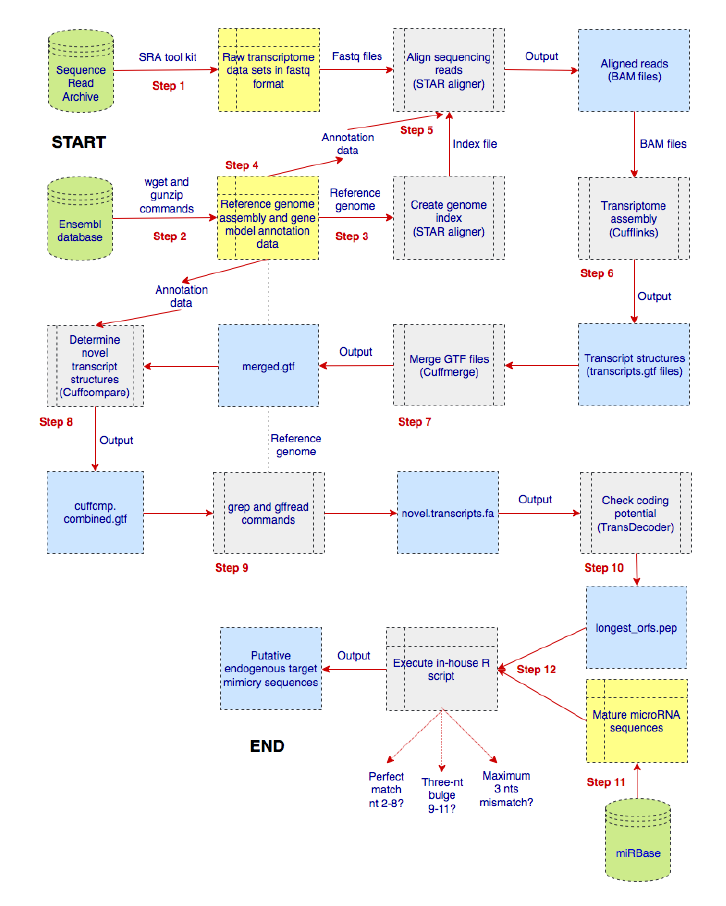
Figure 1: Schematic diagram of the study